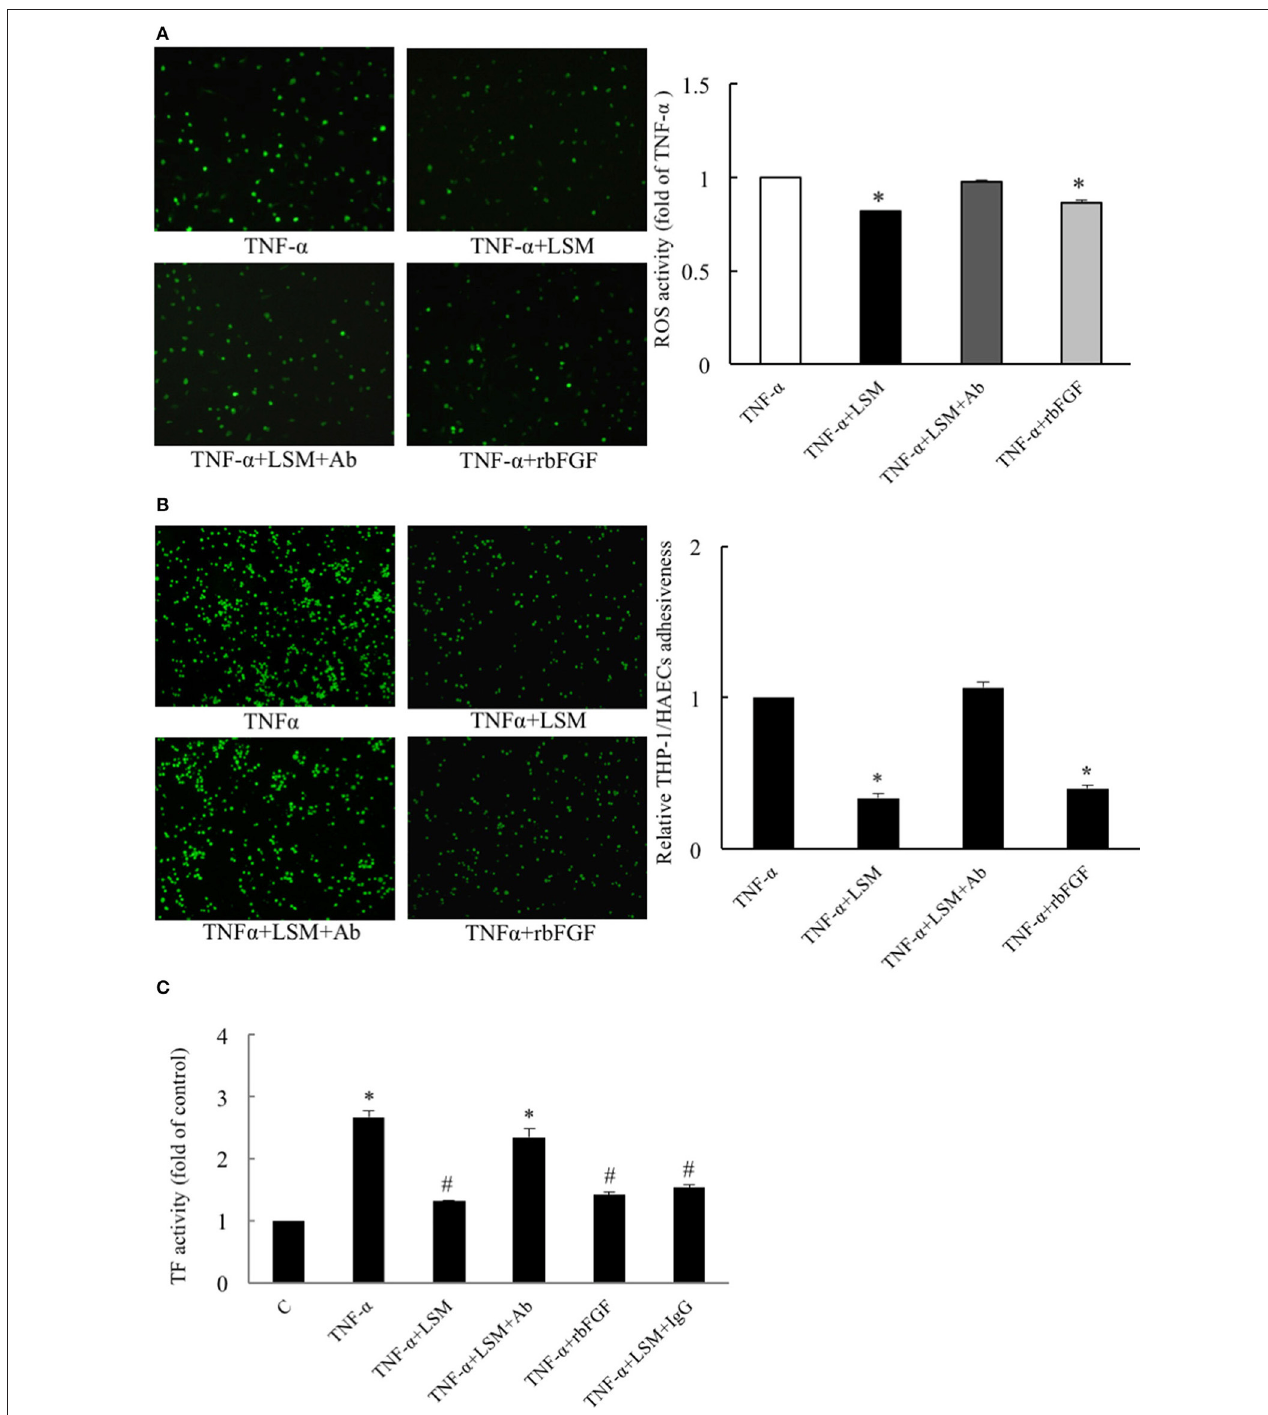
FIGURE 5 | Evaluation of protective efficacies of LSM, rbFGF, and LSM + Ab on TNF- α -induced ROS activity, inflammation, and thrombosis. (A) The TNF- α group displayed a high level of H2DCFDA-dependent ROS activity, while the TNF- α + LSM and TNF- α + rbFGF groups showed significantly attenuated levels (average 0.81- and 0.86-fold) compared to the TNF- α group. (B) Compared to the TNF- α group, the high THP-1/HAECs adhesion ratios were attenuated significantly (average 0.34- and 0.4-fold) in the TNF- α + LSM and TNF- α + rbFGF groups. (A,B) The data are expressed as the mean ± S.E.M. ( n = 4). * p < 0.05 indicates significant downregulation relative to the TNF- α group. (C) Compared to the control group, the highest level of TF activity was increased by 2.66-fold in the TNF- α group. TF activity decreased significantly (average 1.32- and 1.42-fold) in the TNF- α + LSM and TNF- α + rbFGF group compared to the TNF- α group, respectively. However, the TNF- α + LSM + Ab group (average 2.35-fold) was not significantly different from the TNF- α group. The data are expressed as the mean ± S.E.M. ( n = 4). * p < 0.05 and #p < 0.05 indicate a significant difference relative to the control group and TNF- α group, respectively.